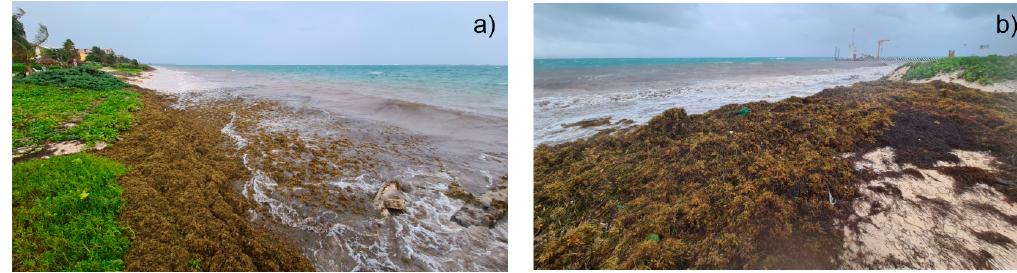
Figure 12. Dunes in Puerto Morelos, with plant growth favoured by sargasso. ( a ) View to the North, and ( b ) view to the South, of the same location.